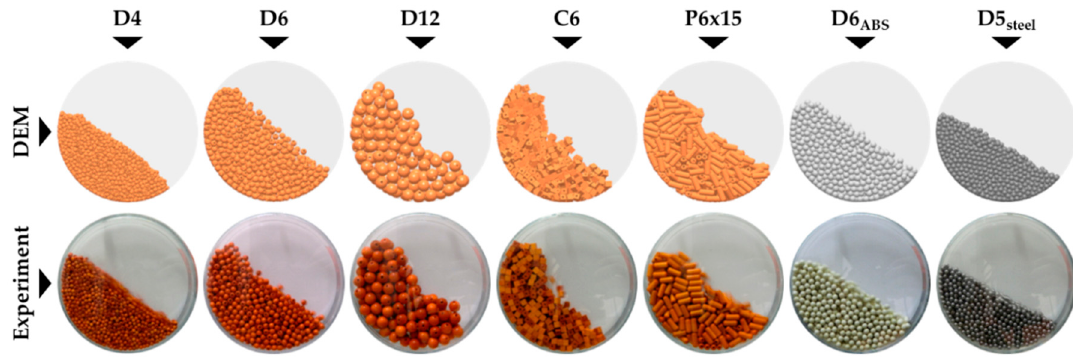
Figure 9. Calibration procedures of virtual particulate materials according to dynamic angle of repose. Table 14. Experimental and calibrated AoR values evaluated via graphical method.